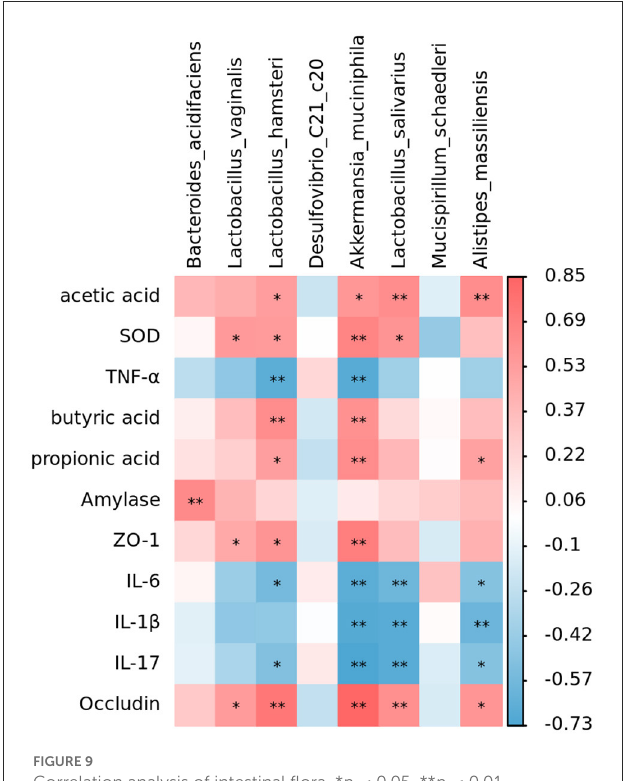
FIGURE9 Correlation analysis of intestinal flora. * p < 0.05, ** p <